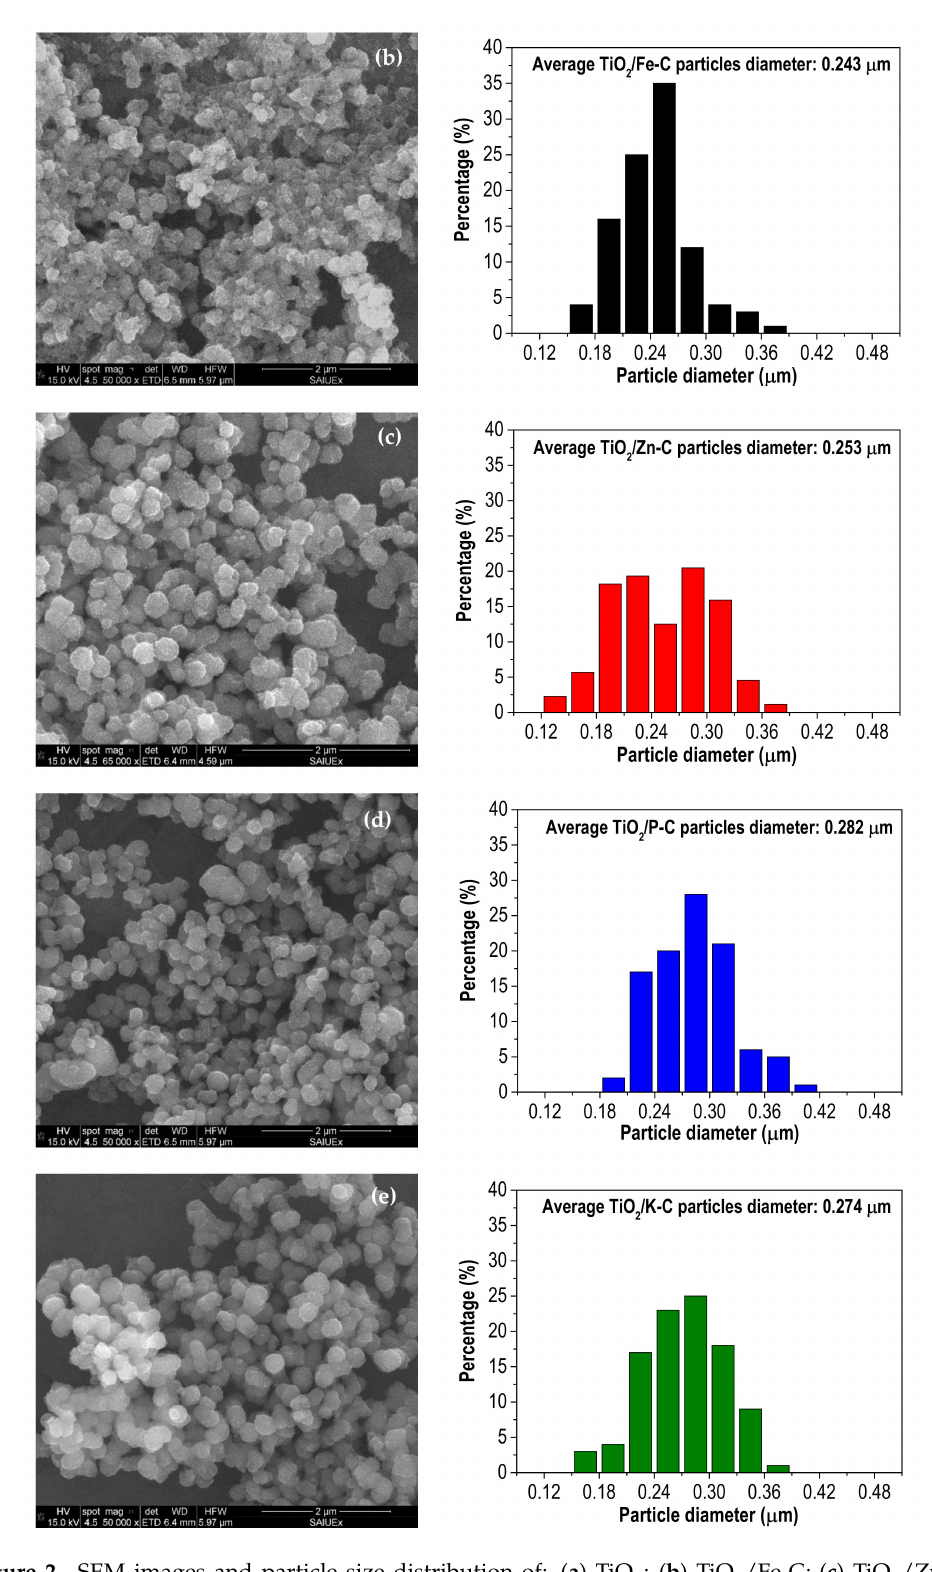
Figure 2. SEM images and particle size distribution of: ( a ) TiO 2 ; ( b ) TiO 2 /Fe-C; ( c ) TiO 2 /Zn-C; ( d ) TiO 2 /P-C; ( e ) TiO 2